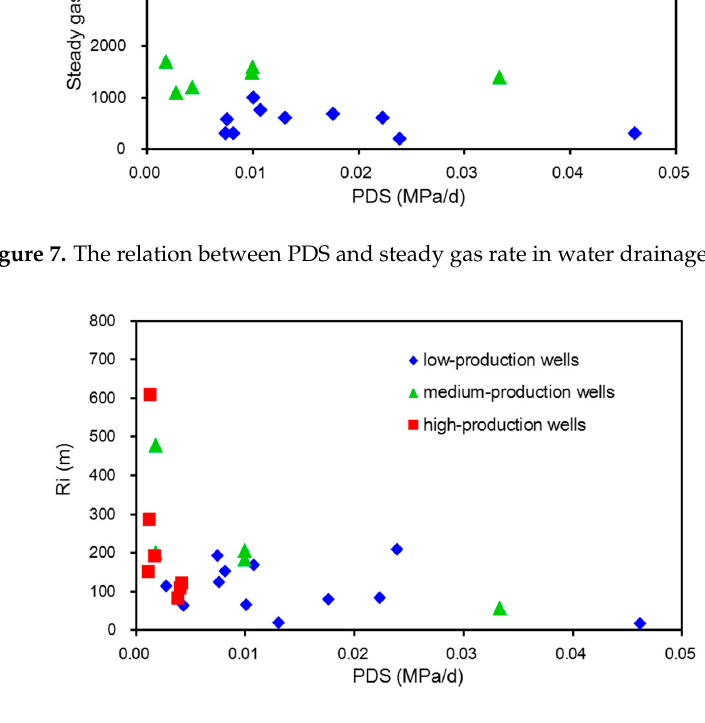
Figure 8. The relation between PDS and investigation radius (Ri) in water drainage stage.